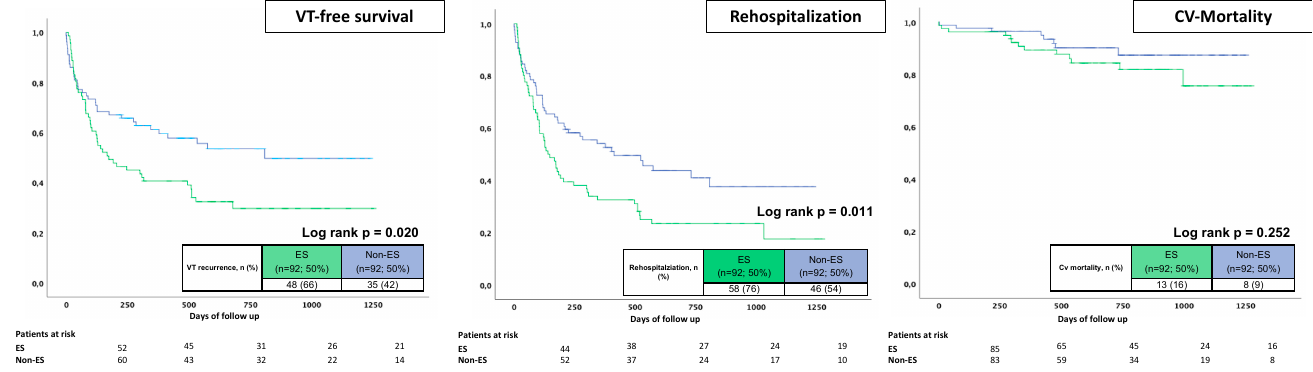
Figure 4. Prognostic impact of ES on VT recurrences ( left panel), rehospitalization rates ( middle panel) and cardiovascular mortality ( right panel) in a propensity score-matched cohort. Prognostic value of (non-)invasive programmed ventricular stimulation (NIPS) before discharge.